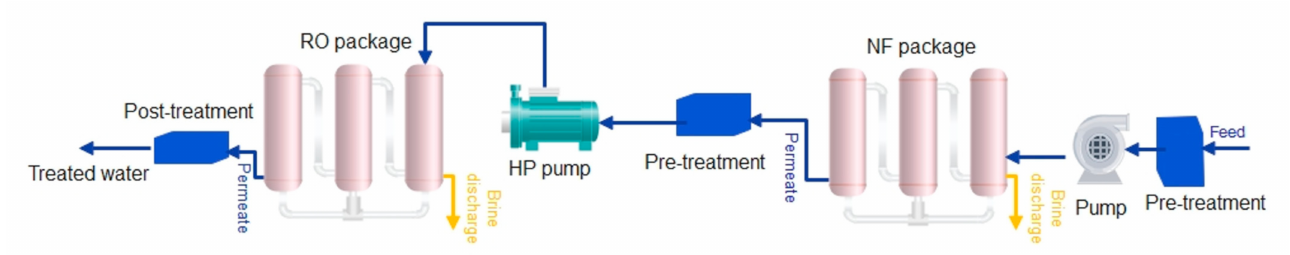
Figure 5. The schematic of the Reverse Osmosis system.